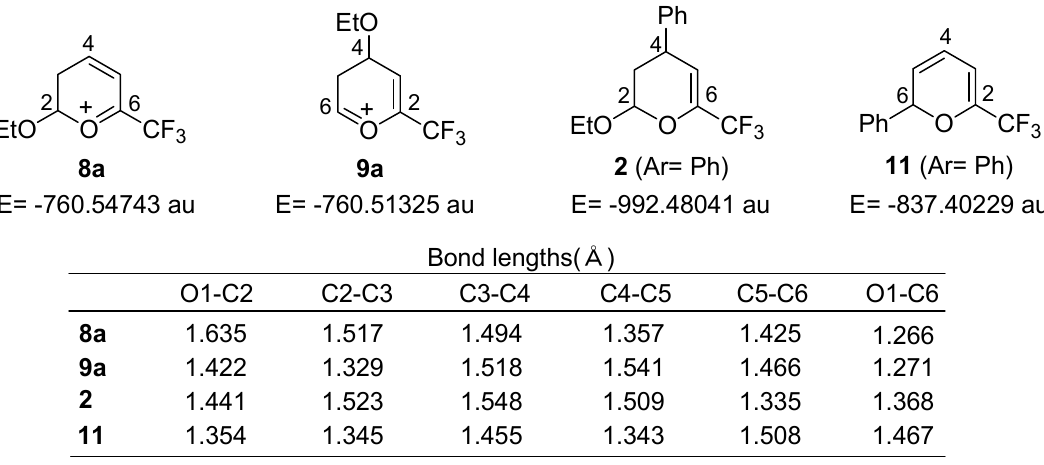
Figure 2. Optimized structures and energy values of intermediates ( 8a , b , 2 , and 11 ).